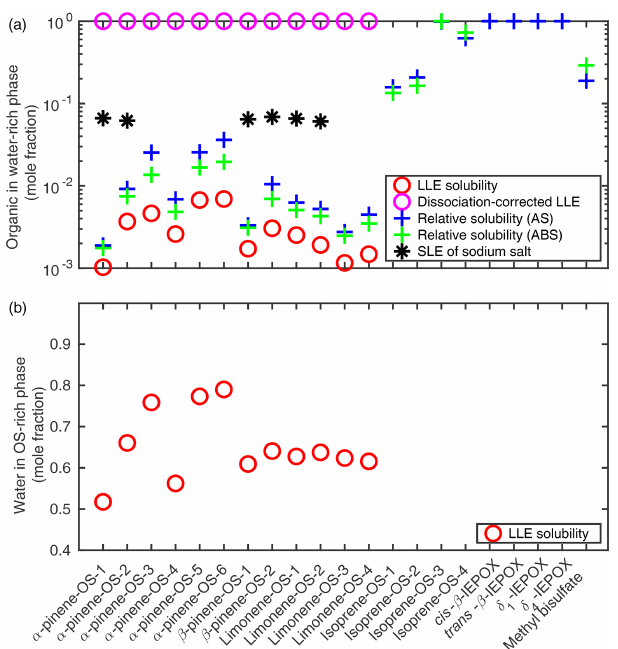
Figure 3. (a) The solubility of organosulfates and their sodium salts in pure water; (b) the solubility of water in the organosul- fate phase ( T = 298 . 15K). Solubilities were estimated using the SLESOL method to solve the liquid–liquid (LLE) or solid–liquid (SLE) equilibrium in COSMO therm . LLE / SLE was not found for the systems with missing points, indicating that the solute is fully miscible with the solvent. Relative solubilities of organosulfates and IEPOX were calculated using the LLE solubility of each compound in 0.09 mole fraction of the inorganic salt (AS or ABS) as a refer- ence for the pure water